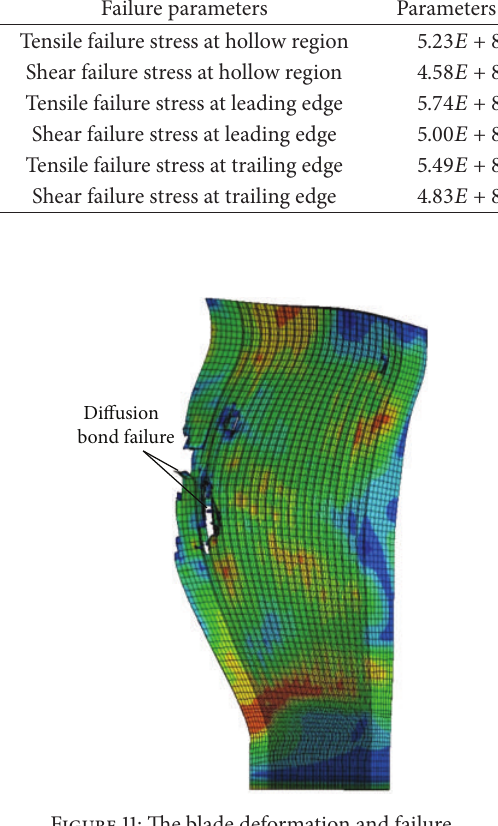
Figure 11: The blade deformation and